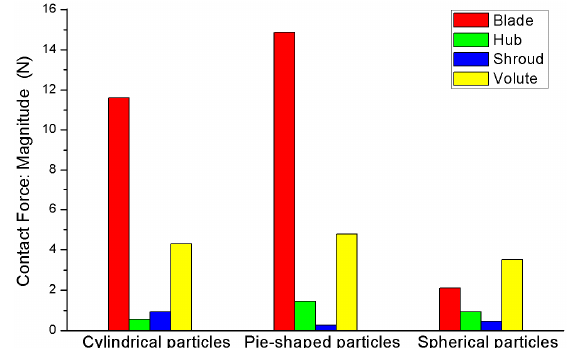
Figure 12. Particle–wall contact force for the three shape cases.